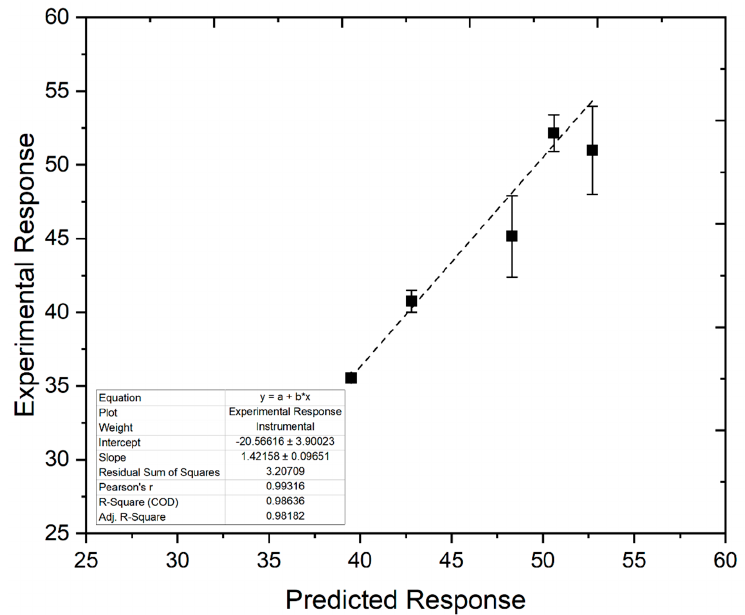
Figure 5. Model predicted vs. experimental response (% degradation of MB) under different experimental conditions.